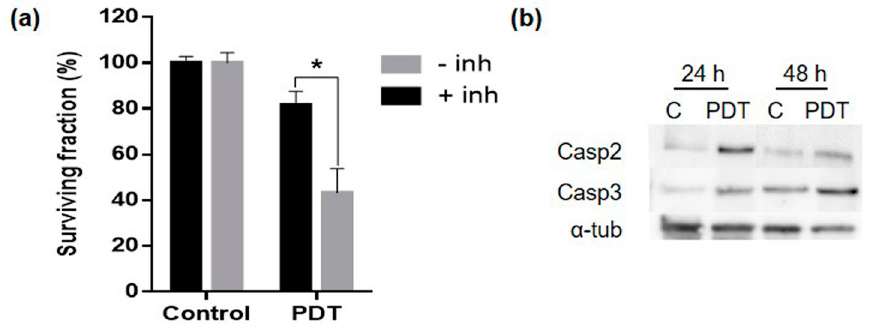
Figure 7. Mechanism of cell death. ( a ) Cell survival percentage after 24 h PDT with or without caspase inhibitor Z-VAD-FMK. ( b ) WB analysis of caspase 2, caspase 3 and α -tubulin 24 and 48 h after PDT. (* p < 0.05).